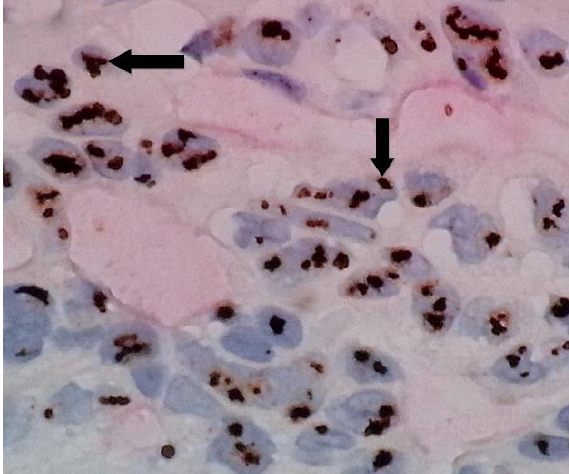
Fig. 10. Invasive Ductal Carcinoma With Huge Amplification of HER2 Gene by Silver DNA in Situ Hybridization Showing Gene Cluster (signal clusters) Formations; the HER2 gene black SISH clusters appear as grape-like formations (arrows) composed of dozens of individual signals. In such cases with huge amplification, the HER2 gene clusters may mask some of the chromosome 17 red ISH signals. Ratio of (black SISH signals/red ISH signals) = 8.5